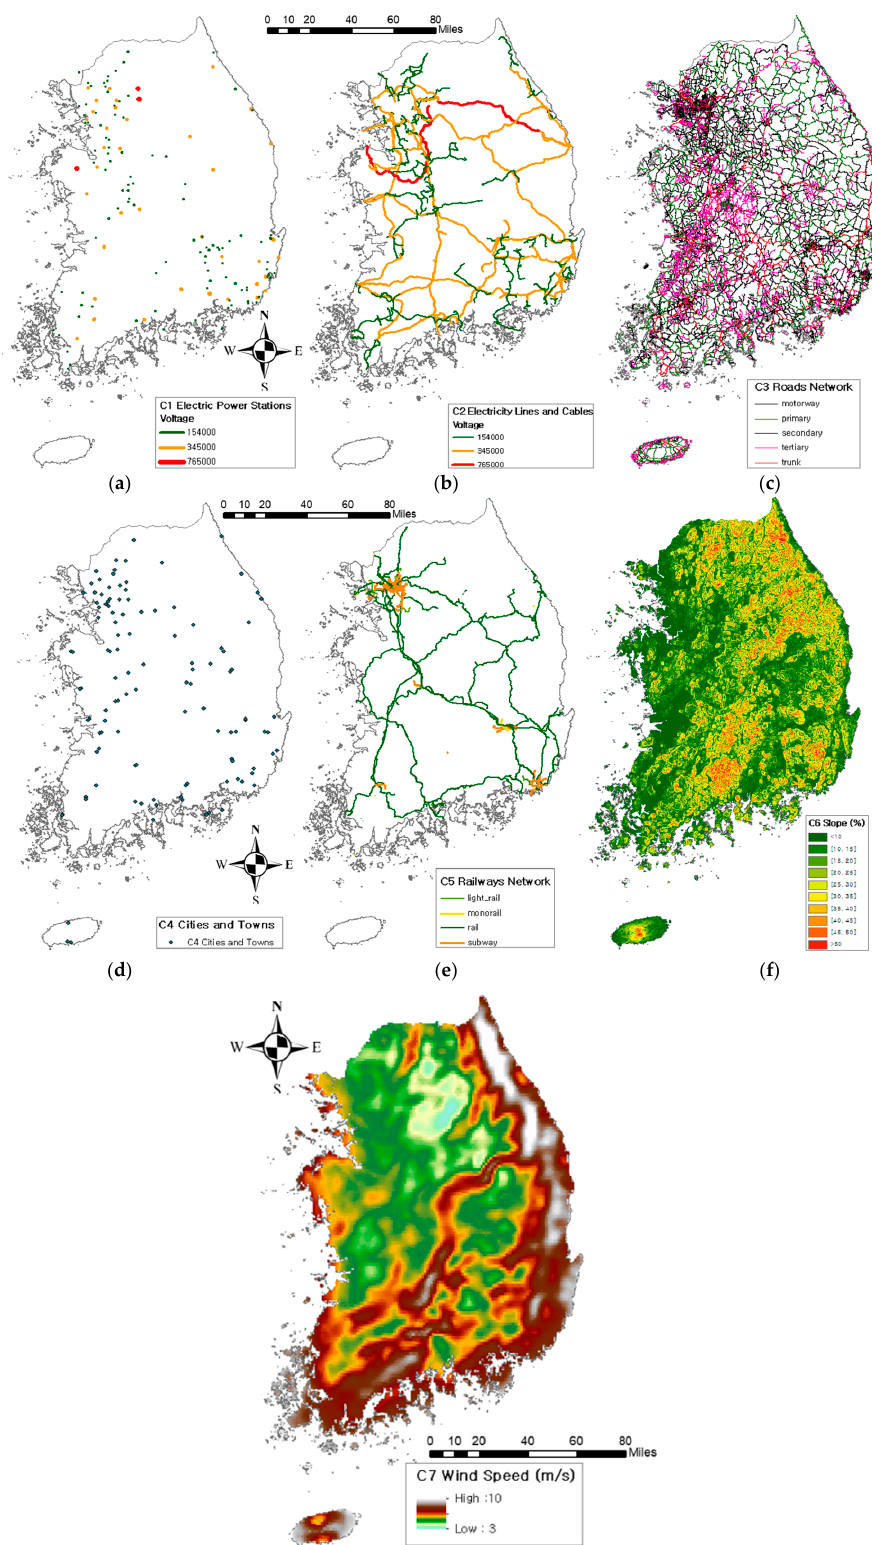
Figure 3. Criterion ( a ) C1: Electric Power Stations ( b ) C2: Electricity Lines and Cables ( c ) C3: Roads Network ( d ) C4: Cities and Towns with population greater than 10 k ( e ) C5: Railways Network ( f ) C6: Land Slope (%) ( g ) C7: Wind Speed (m/s).